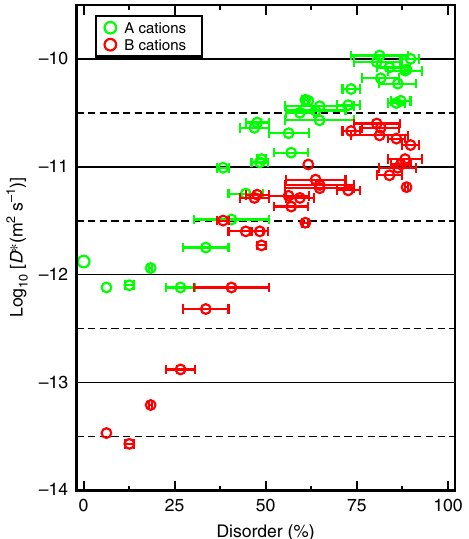
Fig. 5 Non-equilibrium diffusion coef fi cient D ∗ of A and B cations due to vacancy-mediated diffusion in GTO. See text for the description of D ∗ . Diffusion of A and B cations is shown by green and red symbols , respectively. Points obtained by PRD, ParSplice, and MD. The width of the horizontal segments re fl ect the decrease in disorder observed in the material